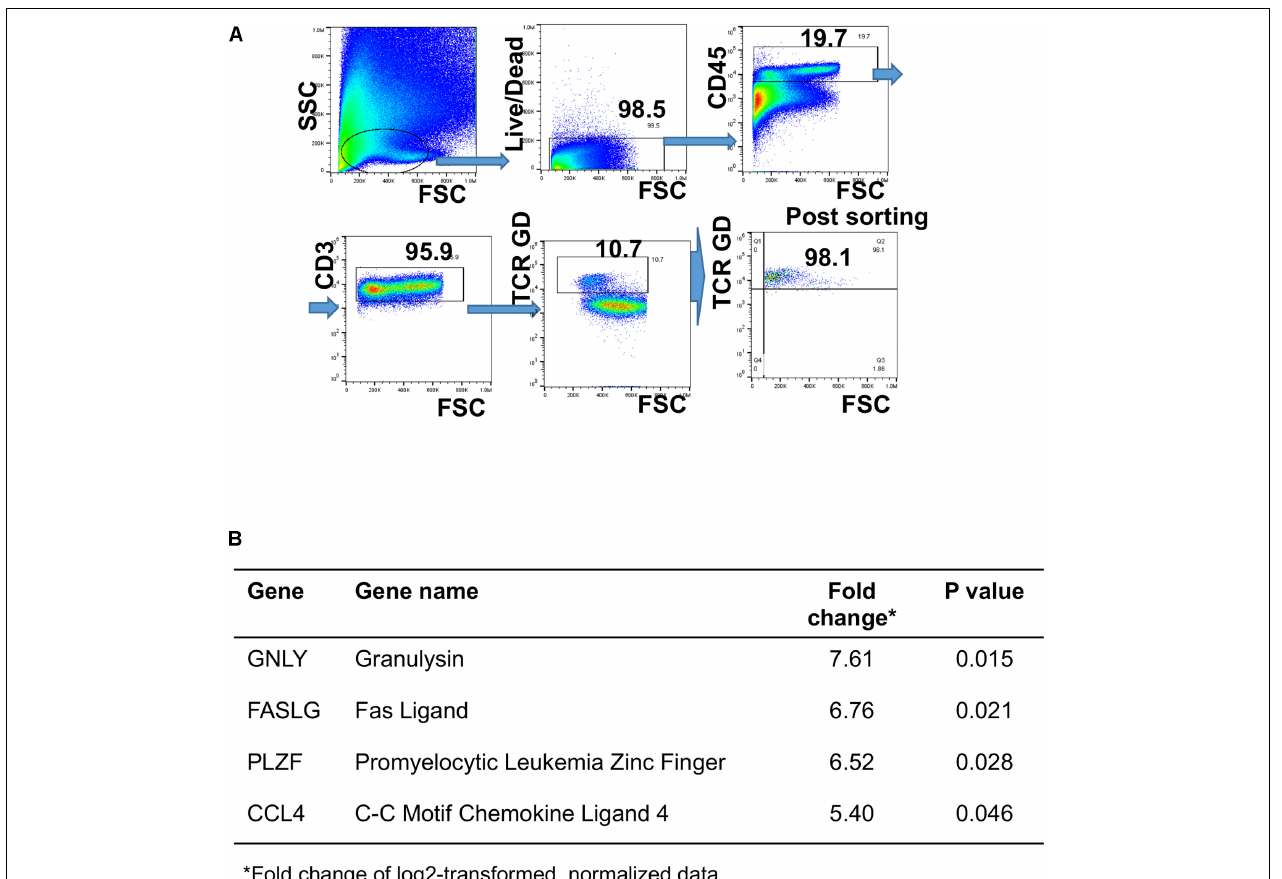
FIGURE 5 | Differential gene expression in human GD T cells as an early response to Staphylococcus epidermidis . Human skin cells were isolated using the Miltenyi Whole Skin Dissociation kit (Miltenyi, Bergisch-Gladbach, Germany) and GD T cells were sorted from the skin cell suspension using fluorescence-activated cell sorting. (A) Gating strategy for GD T cell sorting. (B) Cells were stimulated with S. epidermidis for 1 h and changes in gene expression between uninfected and infected cells were measured using the BioMark IFC 96 × 96 chip (Fluidigm). Changes in gene expression are expressed as log2 of fold change ( n = 3). P -values were calculated using Student t